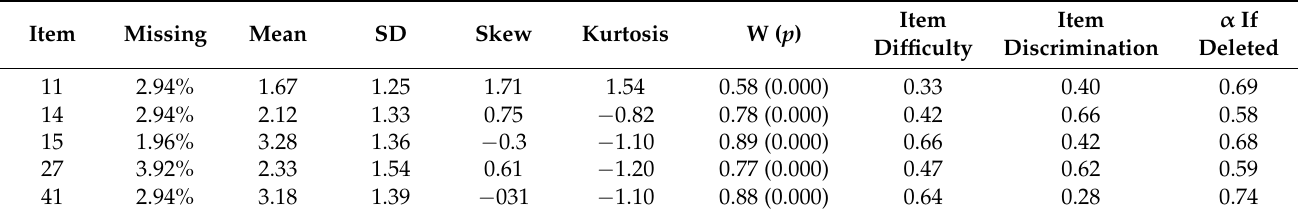
Table 8. The concept of self-image, the gaze of others and the need for